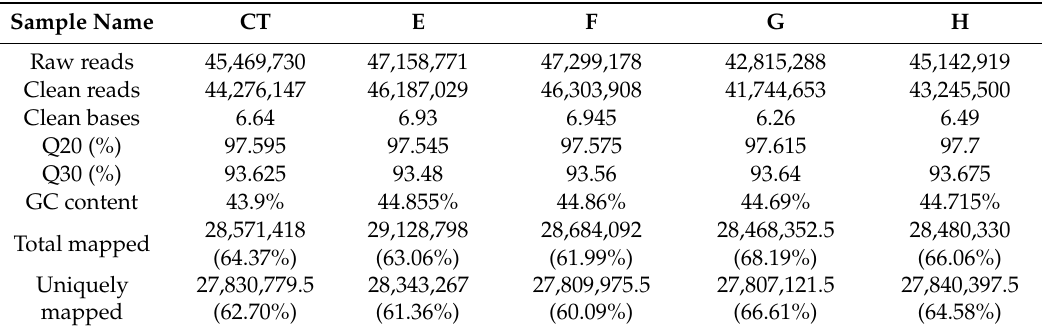
Table 1. Summary of RNA-Seq data and reads